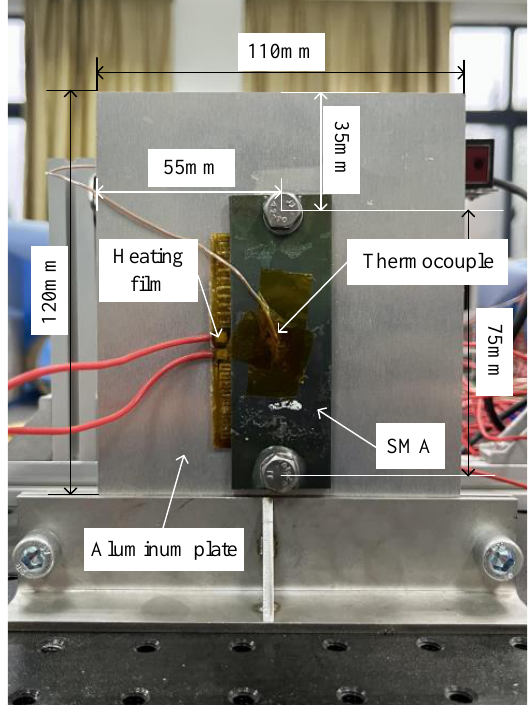
Figure 5. Deflection testing setup for the SMA-based actuator.